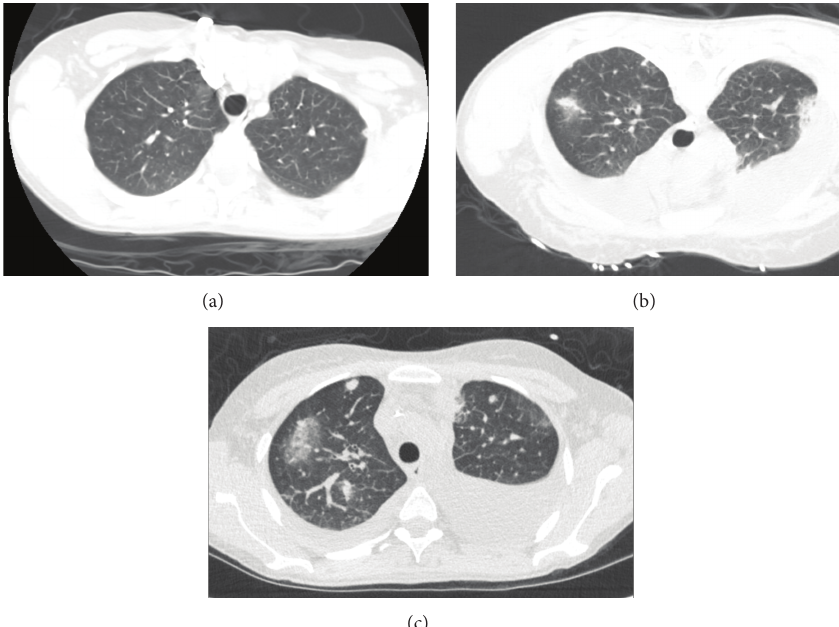
Figure 1: The CT images are taken roughly from the same level. (a) The CT scan on admission. (b) The CT image from the CT guided biopsy showing new nodules. Note that the patient is prone in this image. (c) The CT image is 9 days after admission and shows continued growth and new